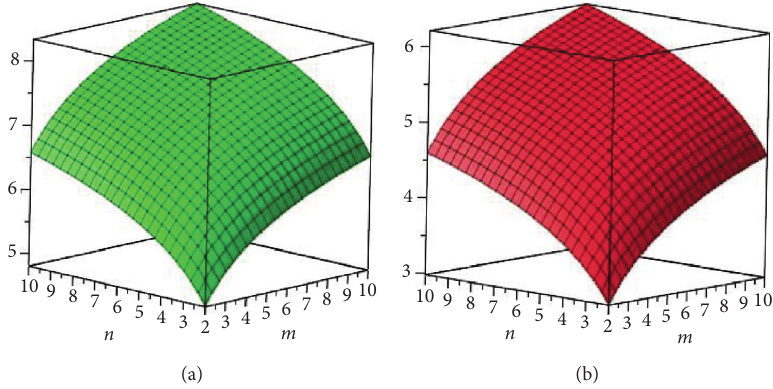
Figure 14: (a) Randi´c entropy for α � ( 1/2 ) ; (b) Randi´c entropy for α � (− 1/2 )